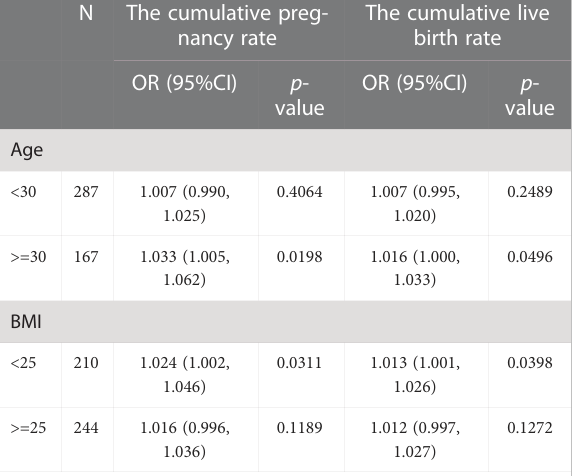
TABLE 6 Strati fi cation analysis of follicular output rate and cumulative clinical outcomes. N